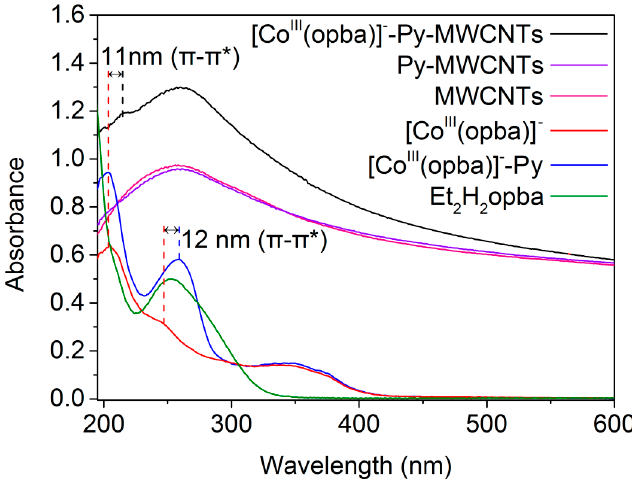
Figure 1. UV-vis adsorption spectra of MWCHTs, Py-MWCNTs, [Co III (opba)] −